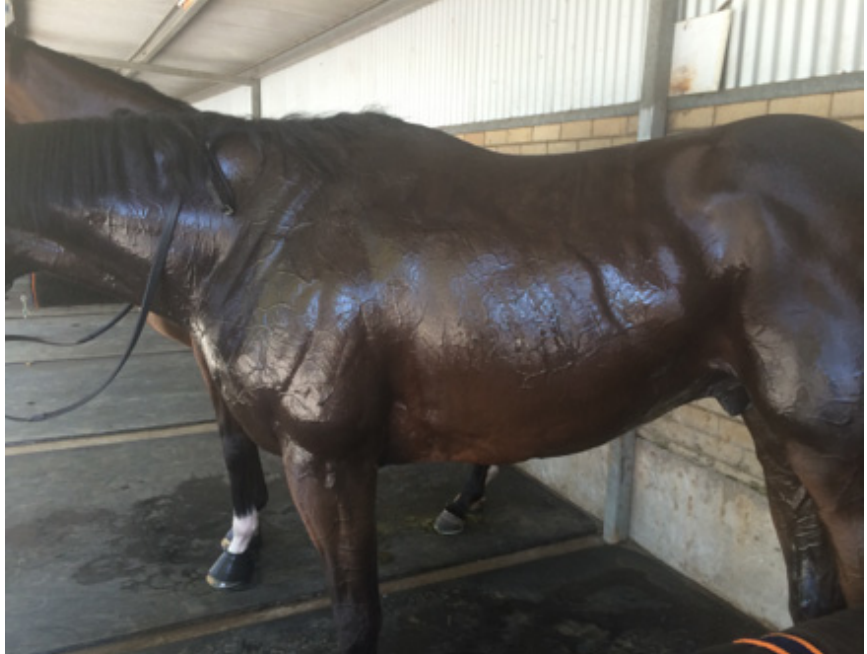
Figure 25. This horse is covered in sweat which is not evaporating because of the environmental conditions on the day and would benefit from being scraped. Source—J Equine Vet Ed, 2021. (6)